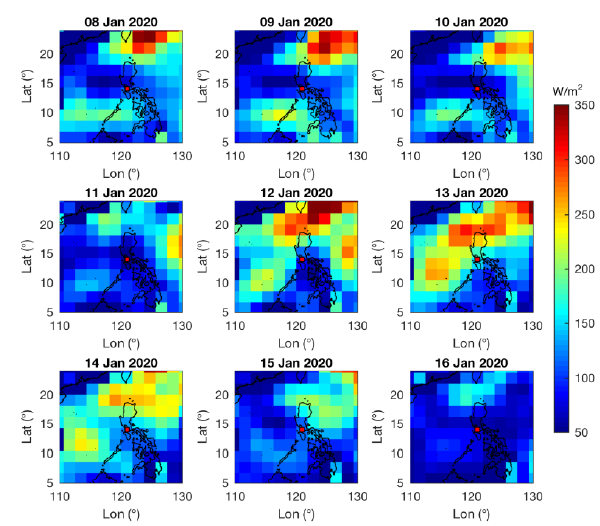
Figure 16. Spatial variations of surface latent heat flux (SLHF) around the region of the Taal volcano between 8 and 16 January 2020. The red square indicates the Taal volcano.